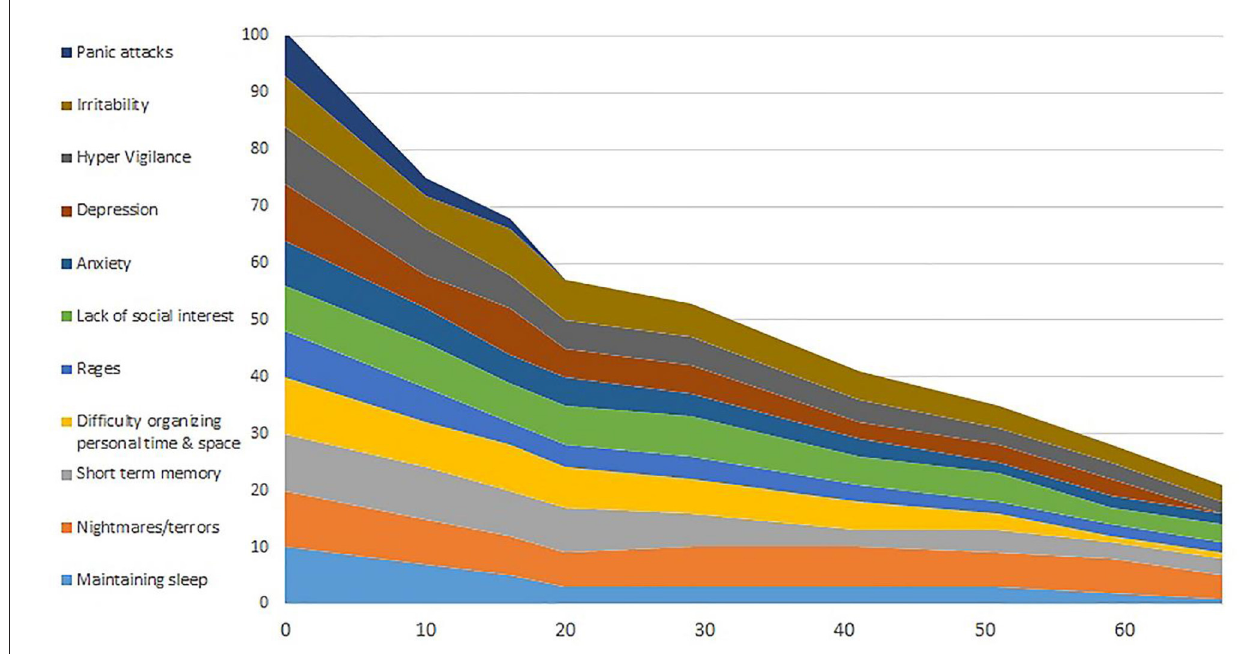
FIGURE 1 | Results of symptom tracking over sessions, which extended over several years. The EEG expert symptom-tracking program was used (www.eegexpert.net).